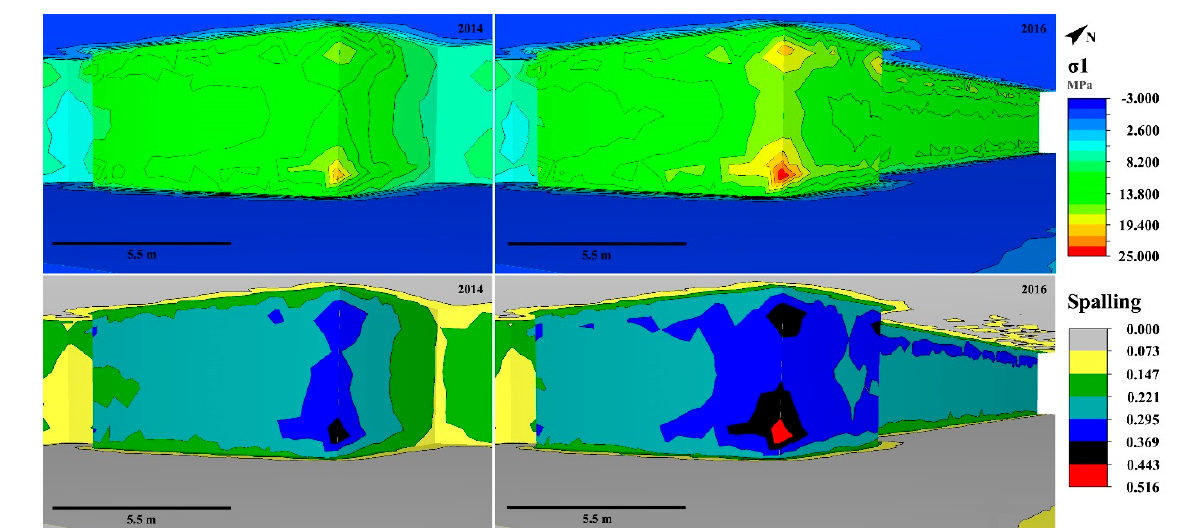
Figure 7. Comparison of major principal field stress σ 1 ( top ) and spalling ratio values (isotropic elastic material- bottom ), as modelled for two scenarios representing two different stages in the Macchietta quarry excavation (year 2014 to the left , and year 2016 to the right ). The scale bar is indicative only.